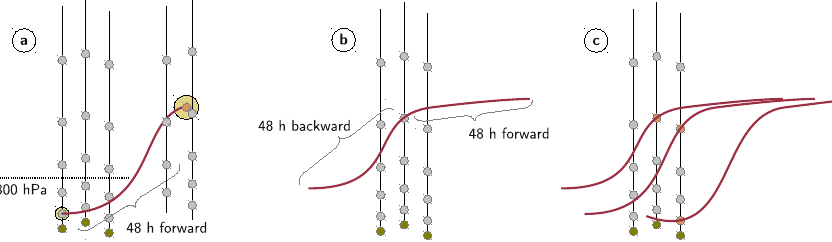
Figure 2. Methods to compute p( WCB ) . (a) ABL-T method using trajectories started in the atmospheric boundary layer and integrated 48h forward in time. To get 3-D gridded information on WCB location, an air parcel volume needs to be assumed for each particle so that grid points overlapping with the volume can be determined. (b) DF-T method using domain-filling trajectories started from every grid point of the p( WCB ) grid and integrated both 48h forward and backward in time. No volume has to be assumed as selected WCB trajectories are located exactly on grid points (c) .